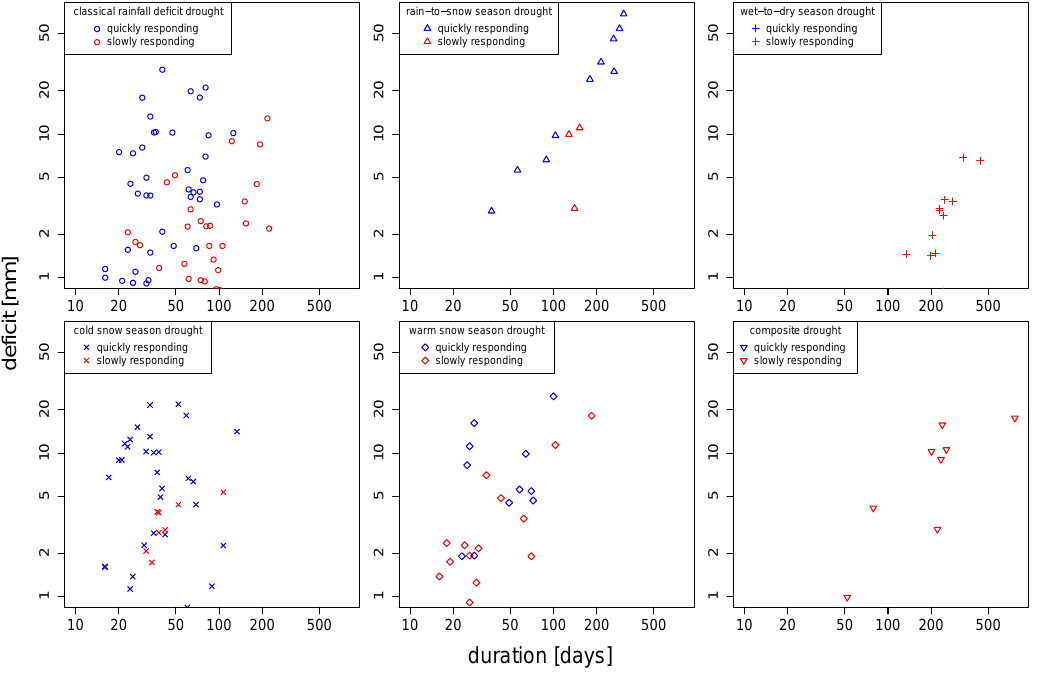
Fig. 12. Drought duration and deficit volume of all discharge drought events grouped per hydrological drought type, on log-log scale, differentiating between quickly and slowly responding catchments (quickly responding: Narsjø and Nedoˇzery catchments; slowly responding: Upper-Metuje, Upper-S´azava, and Upper-Guadiana